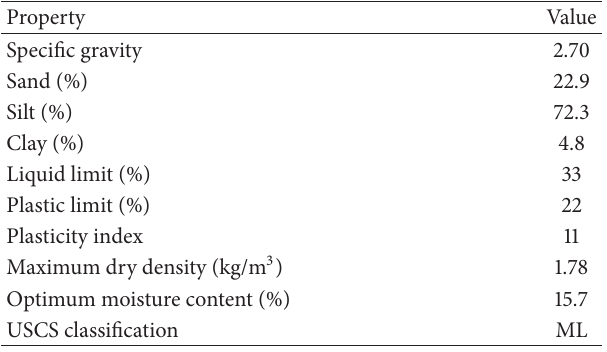
Table 3: Additives used to treat